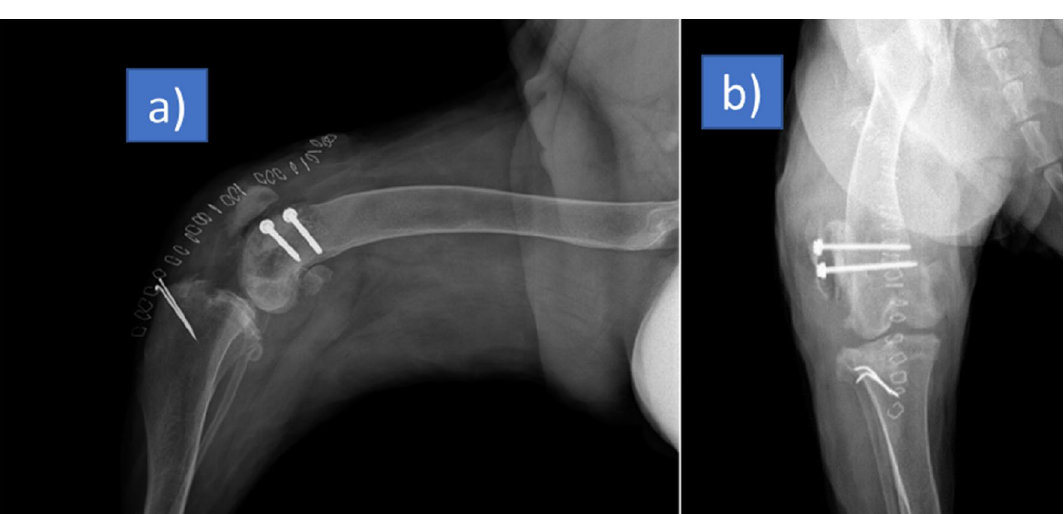
Figure 8. Postoperative rontgen film of the dog. There is no contact between the patella and femur on the lateral view ( a ), patella is on dorsal but slightly lateral side on anterior posterior view ( b ). However, it did not luxate to lateral side spontaneously or with hand. It was stable. The pins on the tibia were applied on previous